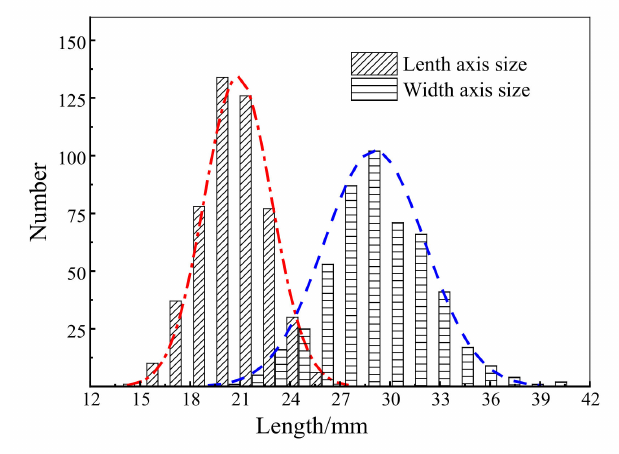
Figure 1. The length and width axis size distribution of 500 fallen jujube fruit